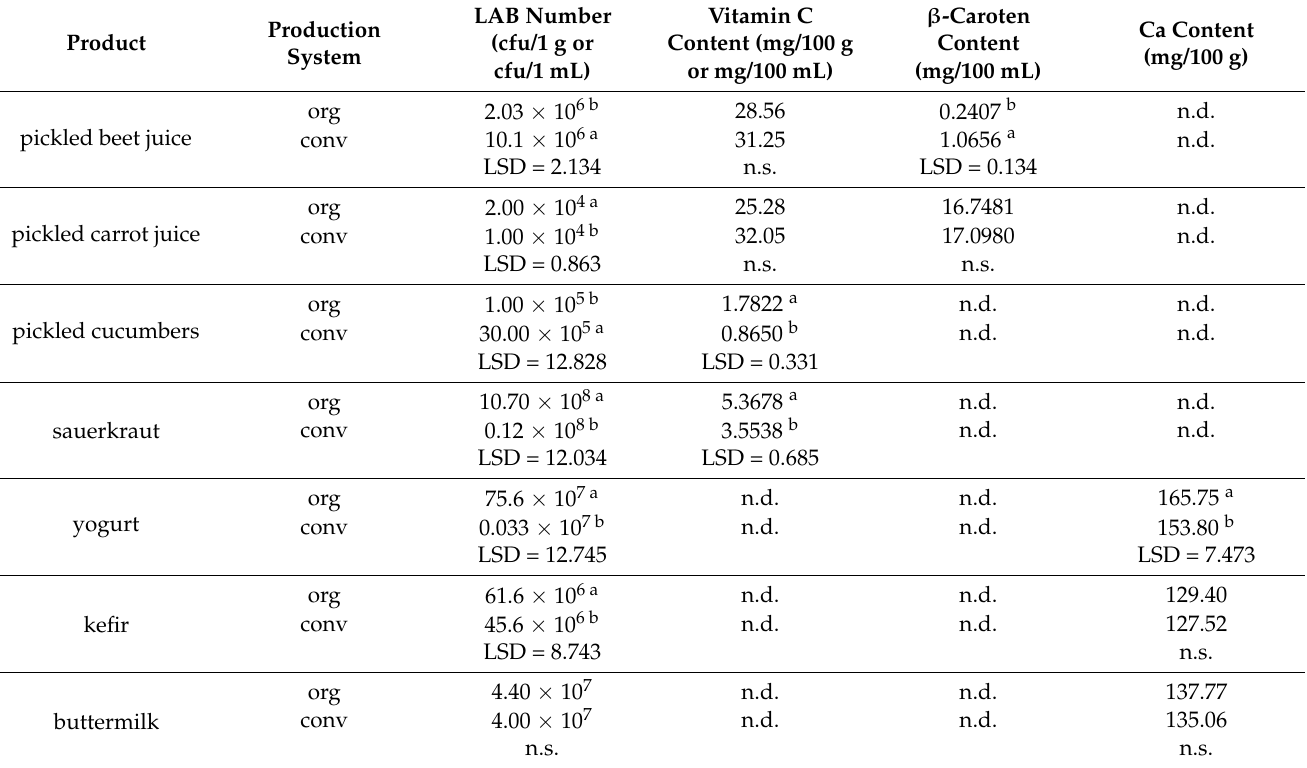
Table 1. Results of qualitative and quantitative analysis of fermented food products from two production